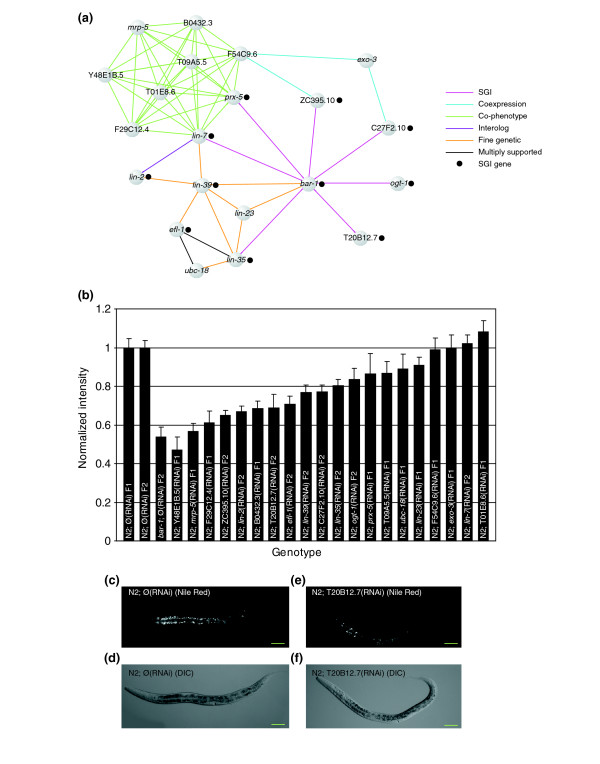
The bar-1 module regulates fat storage and/or metabolism. (a) The 'bar-1 module' of 21 genes was identified by virtue of the interconnectedness of coexpression, co-phenotype, genetic, and protein interactions within the superimposed network. Edges are colored according to the type of supporting evidence. Genes tested for interaction with bar-1 within the original SGI matrix are indicated (black dot). Visualization generated with Visant [86]. (b) Fat accumulation and/or storage disruption in the bar-1 module. Genes in the bar-1 module were targeted by RNAi in an N2 background. The resulting worms were stained with Nile Red and staining was quantified in order to compare values to N2 worms fed negative control RNAi (see Materials and methods). Fifteen of 20 genes show a reduction of Nile Red staining in an N2 background. Values have been normalized with N2 values for each experiment. Error bars represent standard error of the mean. (c,e) Dark-field micrographs of Nile Red staining (shows as bright patches) in N2 worms fed either (c) negative control mock-RNAi (∅ RNAi) or (e) RNAi that targets T20B12.7. (d,f) The corresponding differential interference contrast micrographs are shown below the dark-field micrographs. Scale bar, 50 μm.